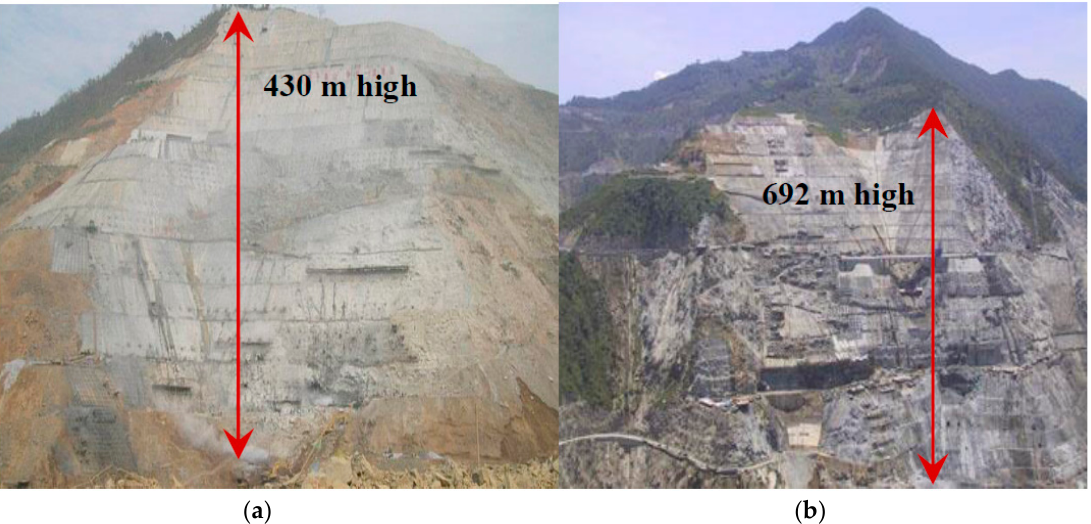
Figure 1. High steep slopes in China related to reservoir safety ( a ) Longtan high steep slope, China ( b ) Xiaowan high steep slope, China.